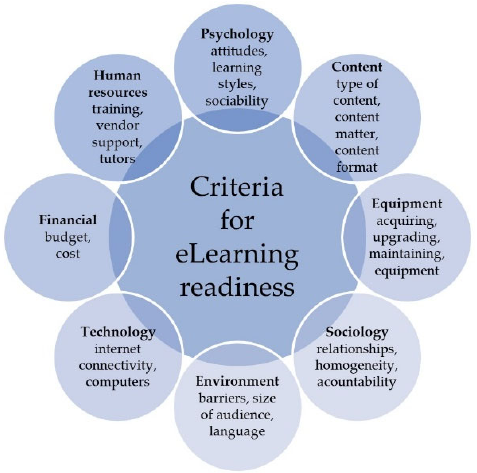
Figure 1. Criteria for eLearning readiness—adapted from Khalid, Jahan and Sobhan [5].